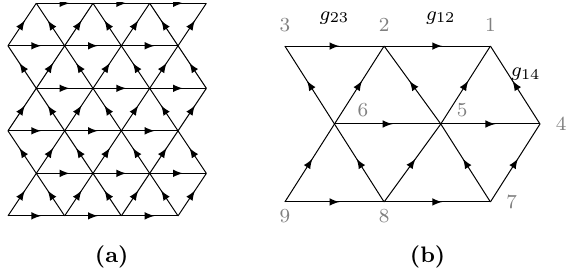
Figure 6 . (a) An example of (one part of) a triangulation of the surface. (b) Ordering labels are assigned to vertices such that the arrows are directed from the greater number to the smaller